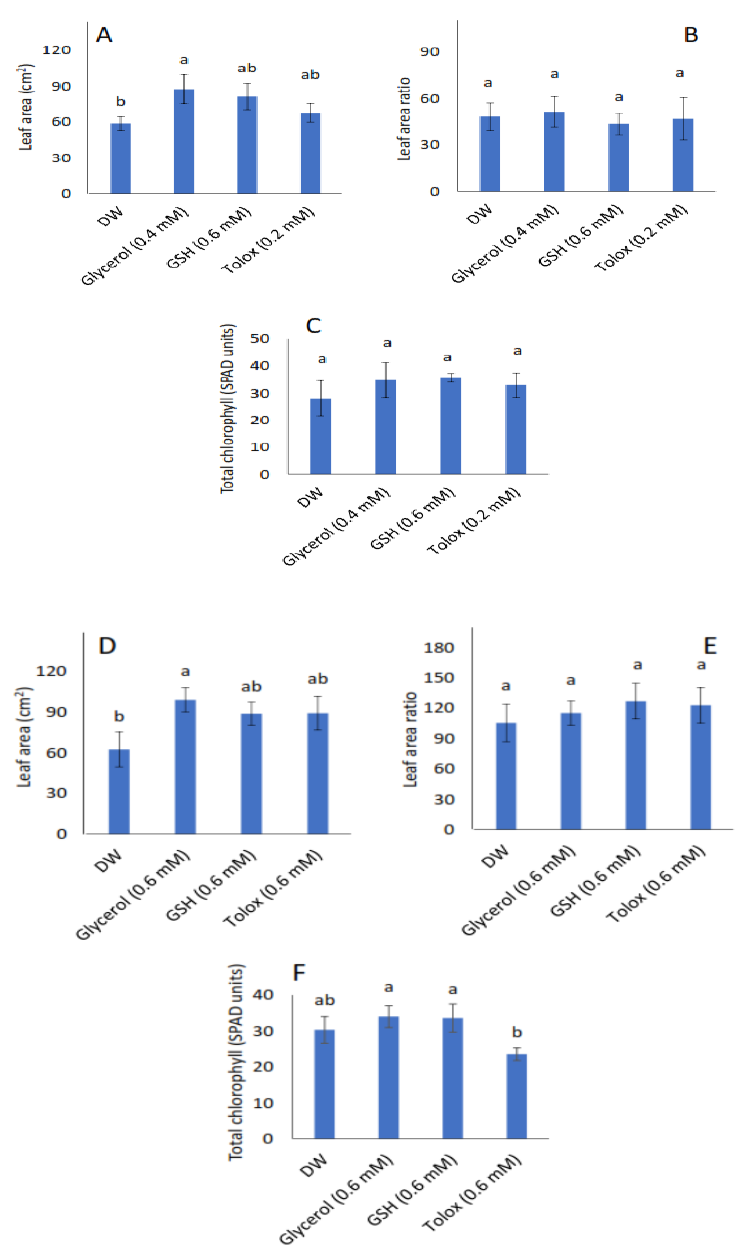
Figure 4. Effect of exogenous application of antioxidants on leaf area ( A , D ), leaf area ratio ( B , E ), and total chlorophyll ( C , F ) in seedlings produced from P25 seeds of cabbage ( B . oleracea ) ( A – C ) and lettuce ( L . sativa ) ( D – F ) subjected to soaking in deionised water (DW), glycerol, glutathione (GSH) or trolox. Values represent mean ± SD (3 × n = 10 for leaf area; n = 5 for total chlorophyll). Bars labelled with different letters indicate significant differences ( p < 0.05, ANOVA).